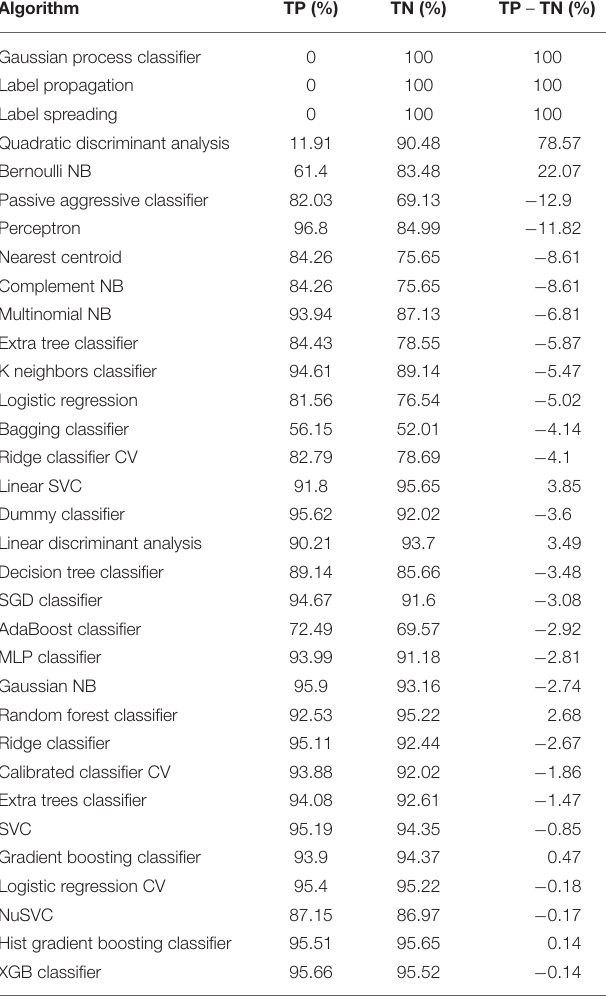
TABLE 1 | Untuned algorithm performance for true positive (TP), true negative (TN), and difference between TP, and TN (TP – TN) performance on the training